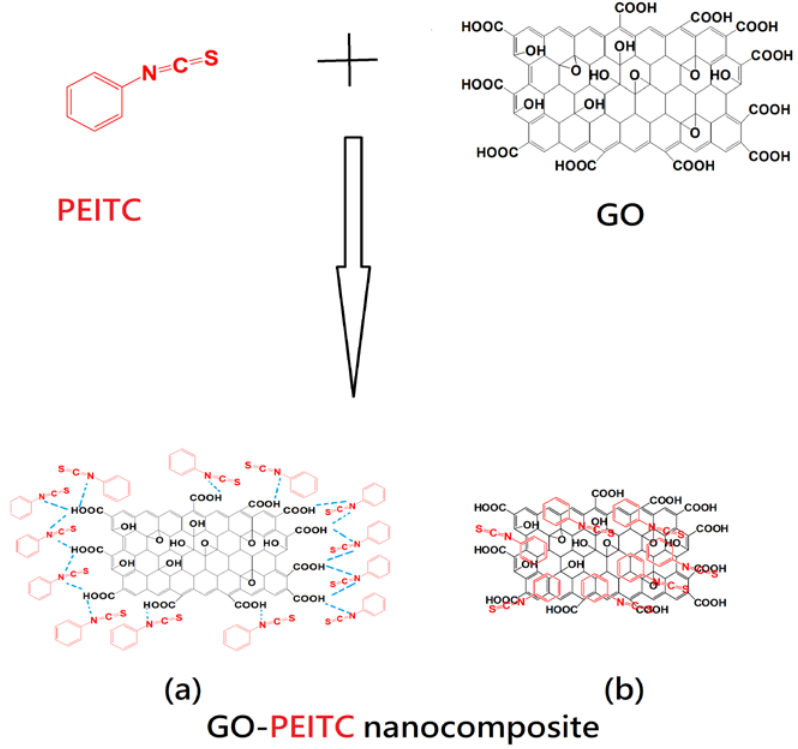
Figure 3. Structure of phenethyl isothiocyanate (PEITC), GO and of the nanocomposite GO-PEITC: ( a ) shows the hydrogen bonding and ( b ) shows the pi-pi stacking between GO and PEITC.